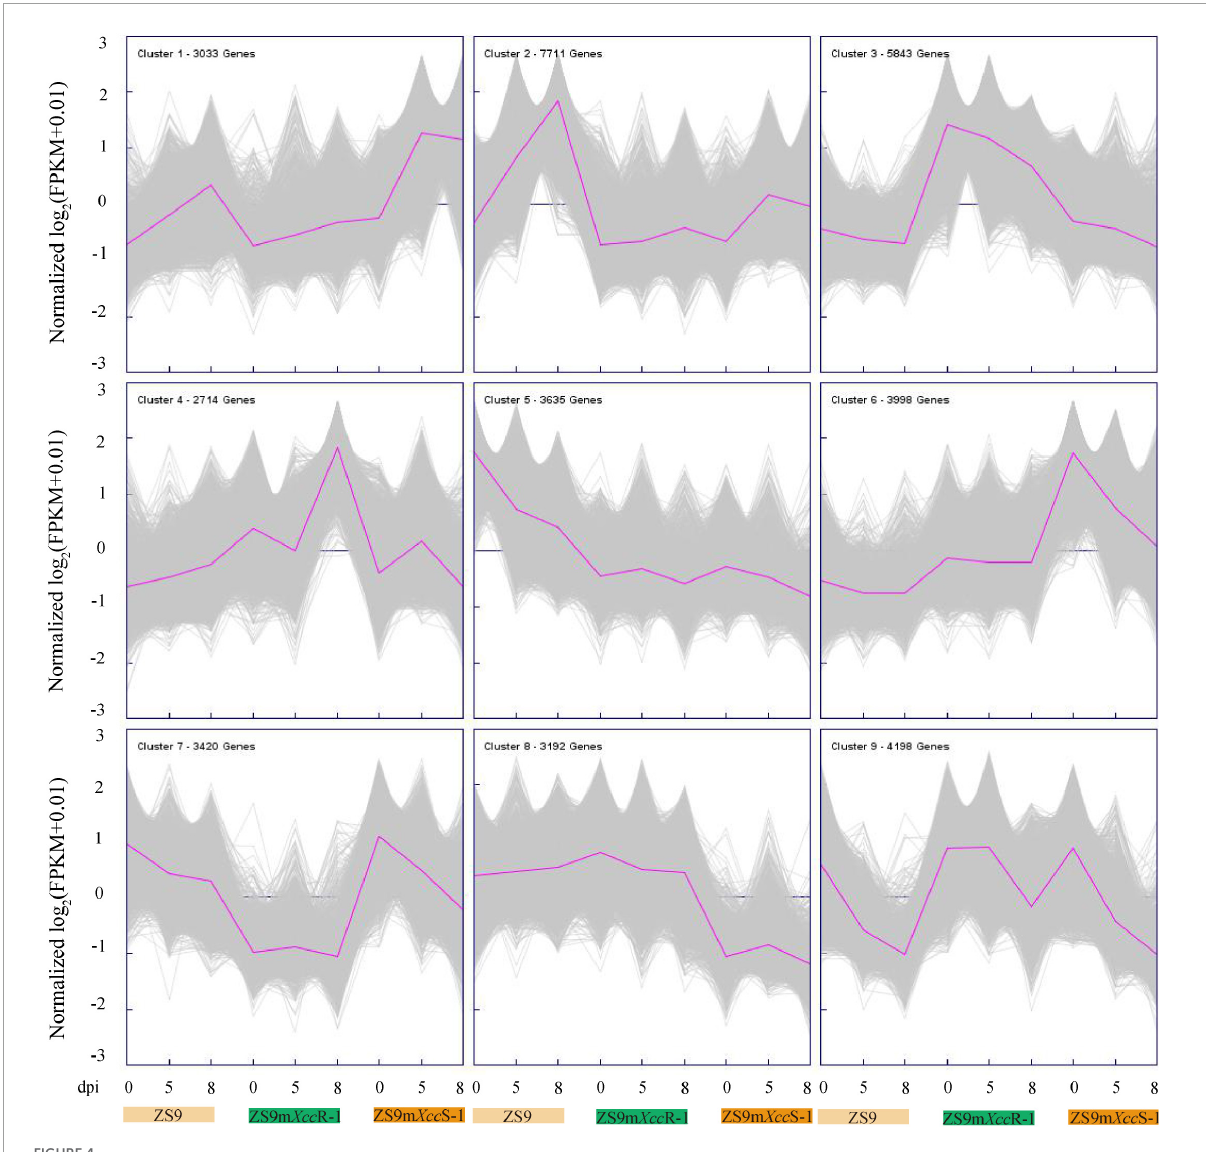
FIGURE4 K-means cluster analysis of 37,744 DEGs. Purple lines indicate average expression levels of the subcluster. Gray lines represent expression levels of each gene within the cluster. The number of genes per cluster is indicated at the left corner of each panel.